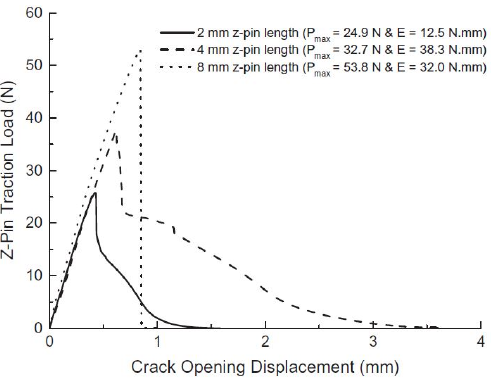
F igure 21. Effect of z-Pin embedment depth on mode I z-Pin response (CFRP z-Pins) [33]. F igure 22. Effect of z-Pin embedment and offset angle on transition point from pull-out to rupture (CFRP z-Pins, d = 0.28 mm, [0/90] pre-preg) [13].